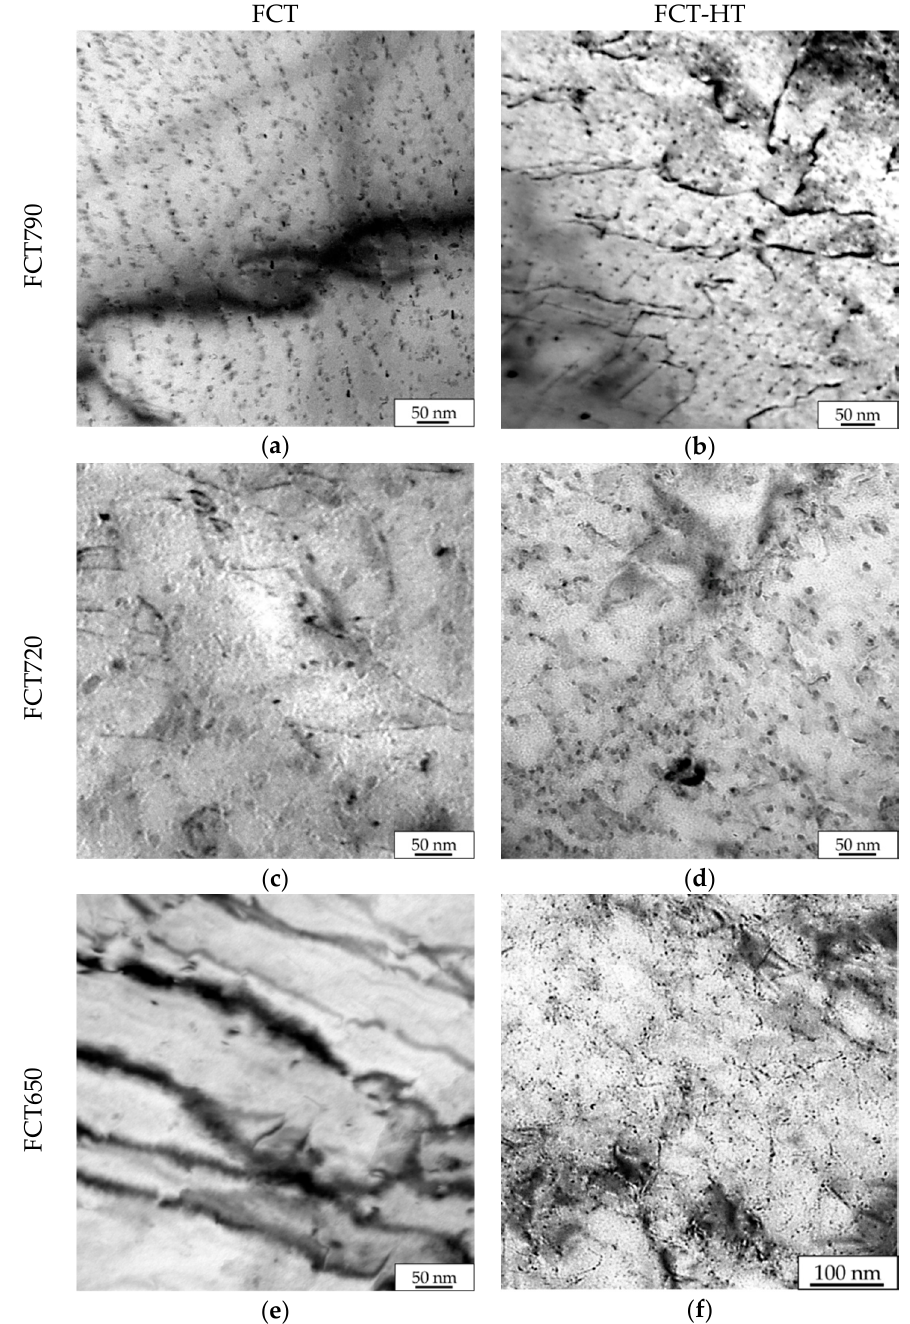
Figure 14. Thin foil TEM micrographs for the entire range of Fast Cooling Temperatures and both ( a , c , e ) FCT and ( b , d , f ) FCT-HT conditions: ( a , b ) FCT790, ( c , d ) FCT720 and ( e , f ) FCT650.